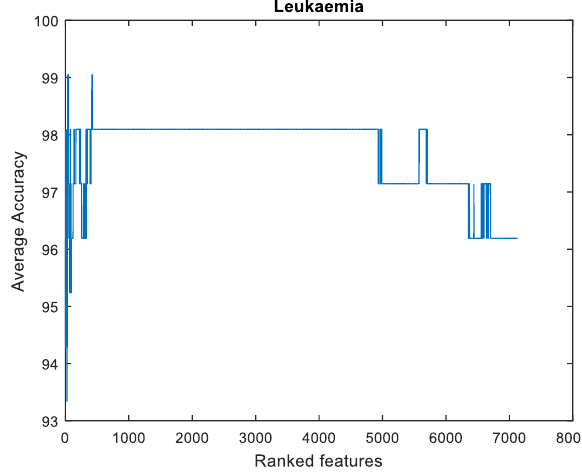
Fig. 3. The average accuracy of the ranked features for the leukaemia